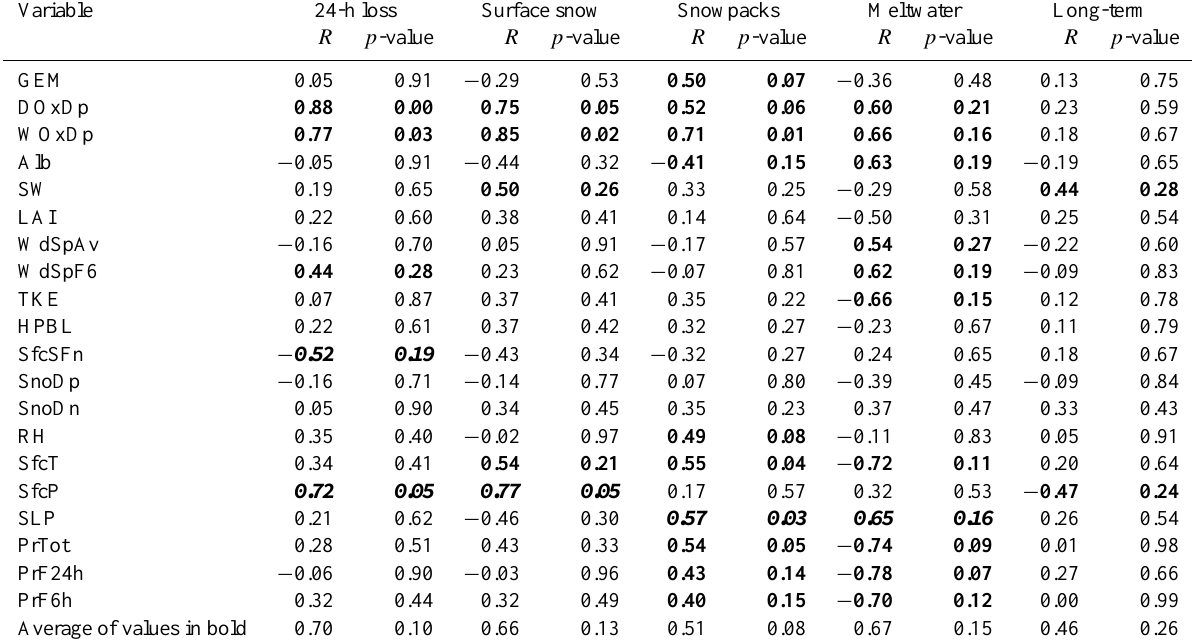
Table 11. Results of bivariate linear regressions for Set2. Bold font indicates parameters that are sufficiently strongly ( | R | ≥ 0 . 35) and significantly ( p -value ≤ 0.30) correlated; italics indicate falsely correlated parameters.